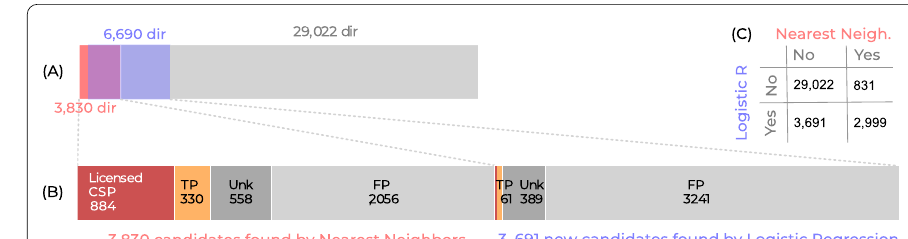
Figure 4 Number of directors flagged and validated in our approach. ( A ) The nearest neighbor approach (red) identifies 3830 directors as potential CSPs, while the logistic regression (blue) identifies 6690 (3691 new ones). ( B ) Amongst the directors flagged by the nearest neighbors approach, 886 correspond to licensed CSPs, 330 to illegal CSPs (TP), 2056 to non-CSPs (FP), and we were not able to determine the status of 558 of them (Unk). Amongst the new directors flagged by the logistic regression approach, 12 correspond to licensed CSPs, 61 to illegal CSPs (TP), 3241 to non-CSPs (FP), and we were not able to determine the status of 389 of them (Unk). The estimates of false positives, true positives and unknowns were obtained using the Bayes rule with a uniform prior and a binomial likelihood. The median of the posterior distribution